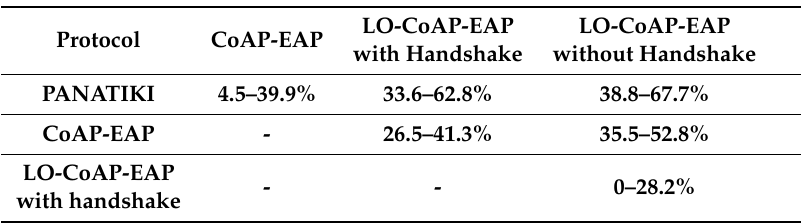
Table 4. Comparing the improvement of network authentication Time among PANATIKI,